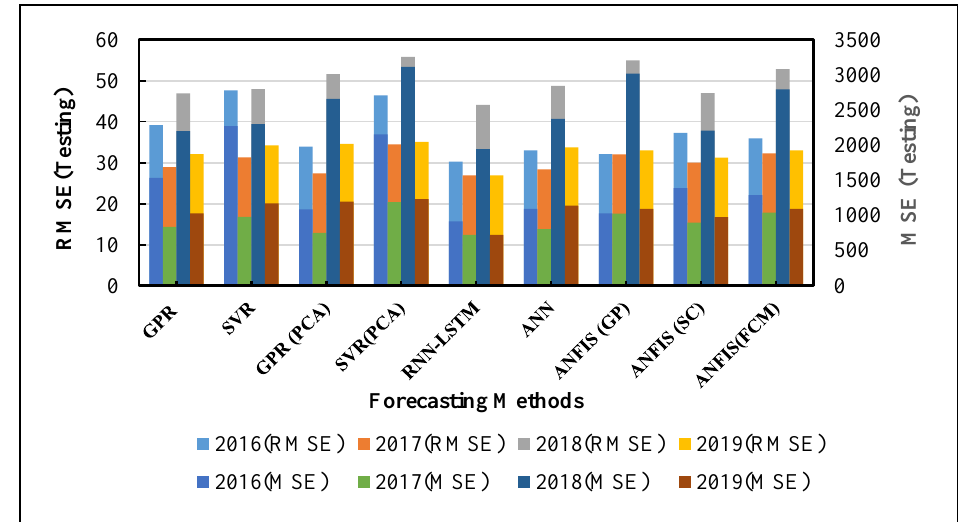
Figure 7. Comparison of RNN-LTSM test results of RMSE and MSE for p-si with other techniques over the period of four year (2016–2019).